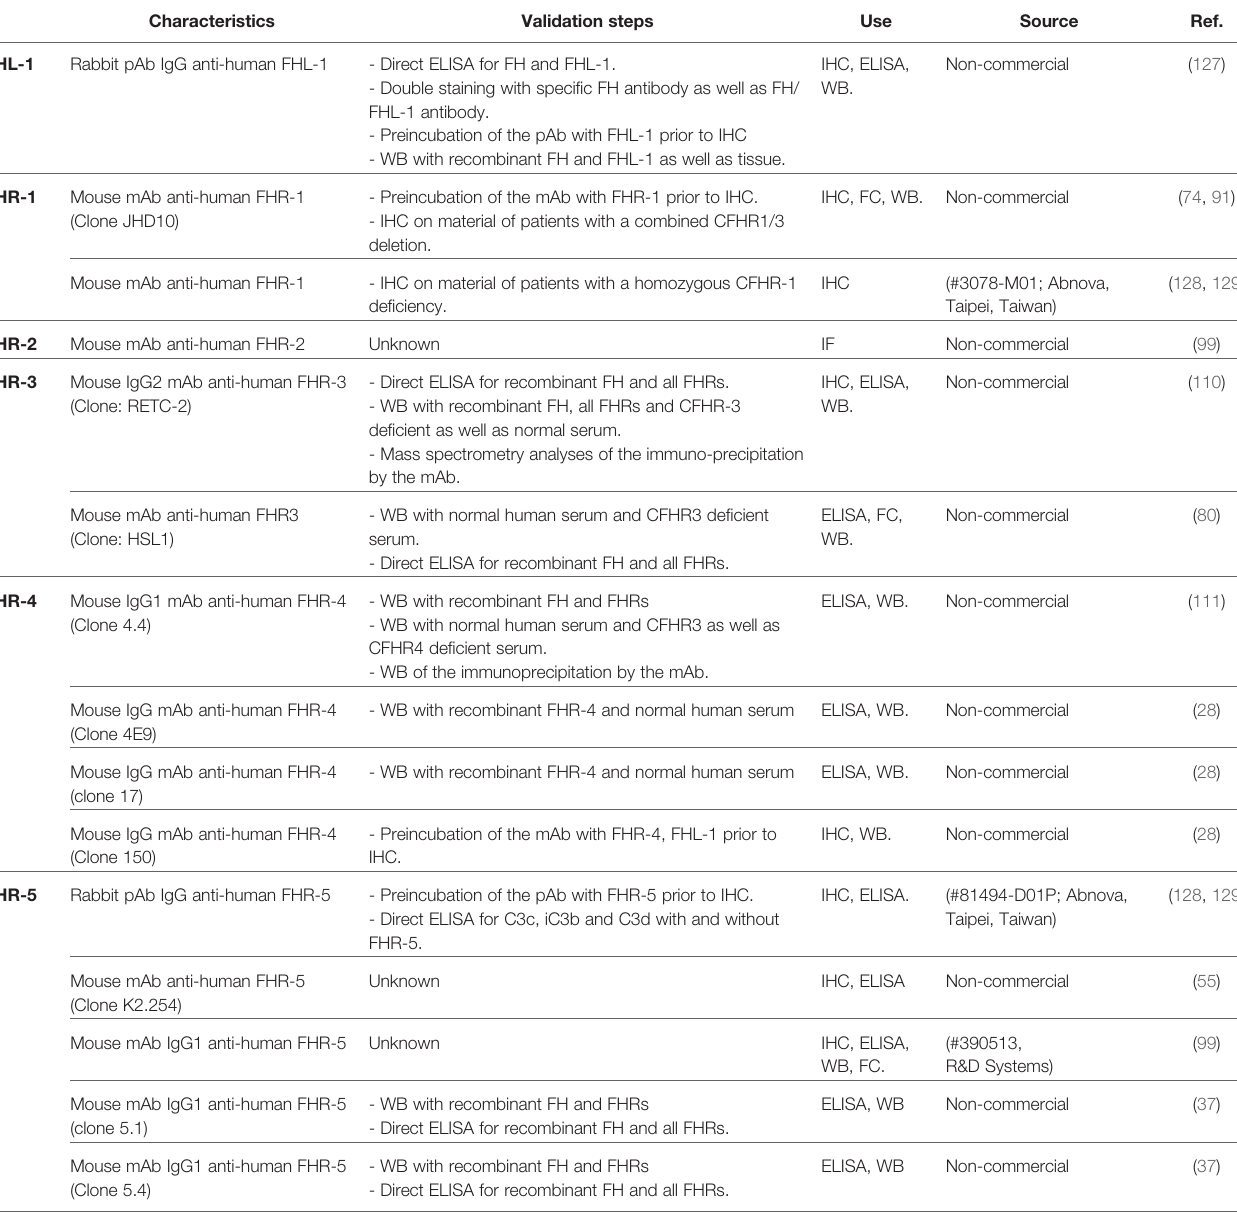
TABLE 3 | Published antibodies that have been proposed to be speci fi c for each of the Factor H-related